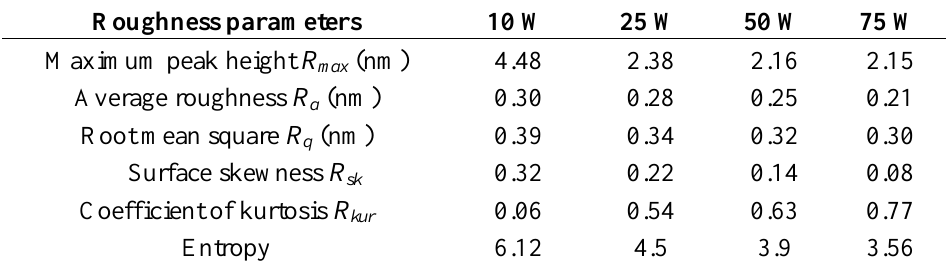
Table 3. Roughness parameters of pp–GT thin